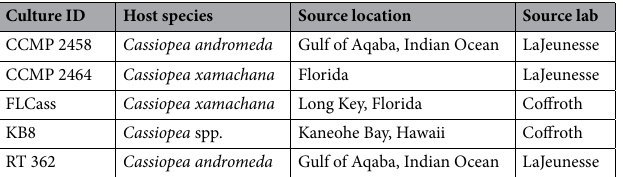
Table 1. Source information for genotypes of Symbiodinium microadriaticum